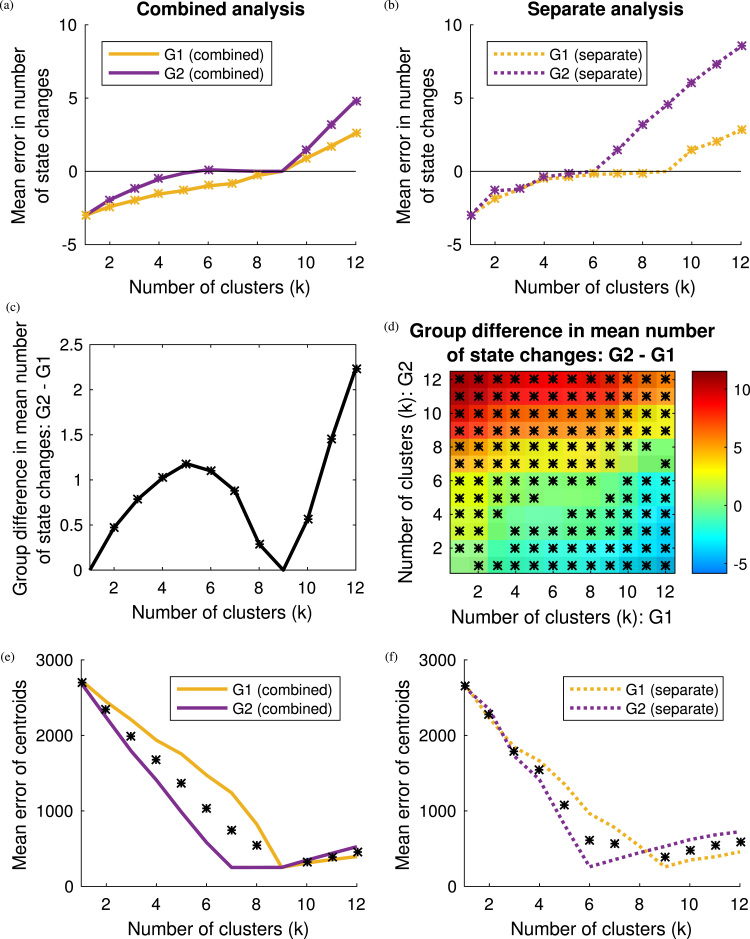
The true number of FC state transitions in this simulation is 3. Individuals in G1 could reach 9 FC states while individuals in G2 could reach only 6 of these 9 FC states. (a) When k<9, the combined analyses underestimated the number of FC state transitions for G1 (solid yellow line), while the number of FC state transitions for G2 (solid purple line) was recovered more accurately. (b) The separate analysis showed an improvement in the error in number of FC state transitions for G1 (dotted yellow line) when k was underestimated. (c) Unless k was correctly estimated, the combined analysis yielded an incorrect group difference in number of FC state transitions. (d) For the separate analysis, incorrect group differences were only found when k was overestimated or grossly misspecified for either group. (e) In terms of recovered space-time connectivity structure, the combined analysis performed better for G2 (solid purple line) than G1 (solid yellow line) when k was underestimated. (f) If k was correctly specified or only slightly misspecified for either group, the separate analyses had a similar error in recovered connectivity structure. Asterisks in (a) – (d) indicate a statistically significant (p<0.05) difference from zero, according to a Wilcoxon signed-rank test, while asterisks in (e) – (f) indicate a statistically significant (p<0.05) difference between the two groups, according to a two-sample Wilcoxon rank-sum test.